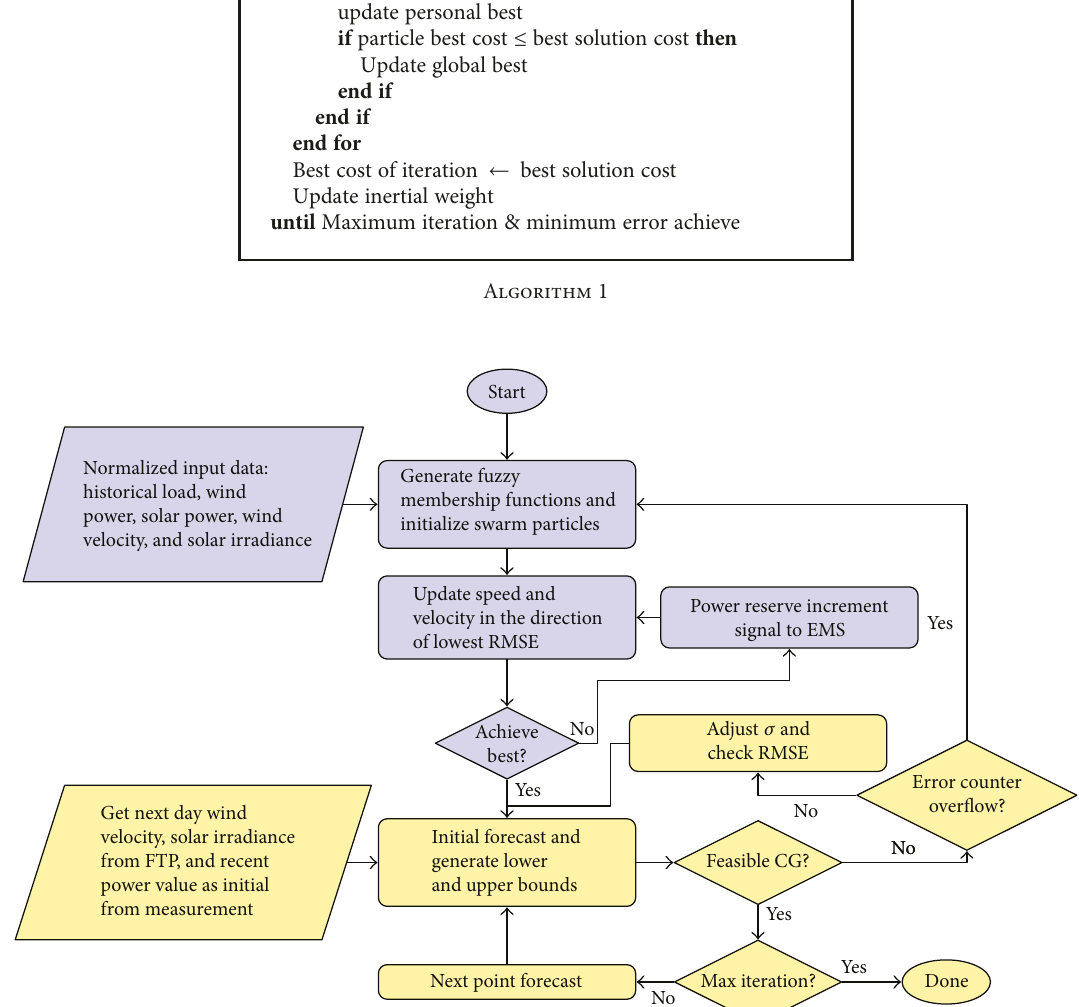
Figure 2: Flowchart of the